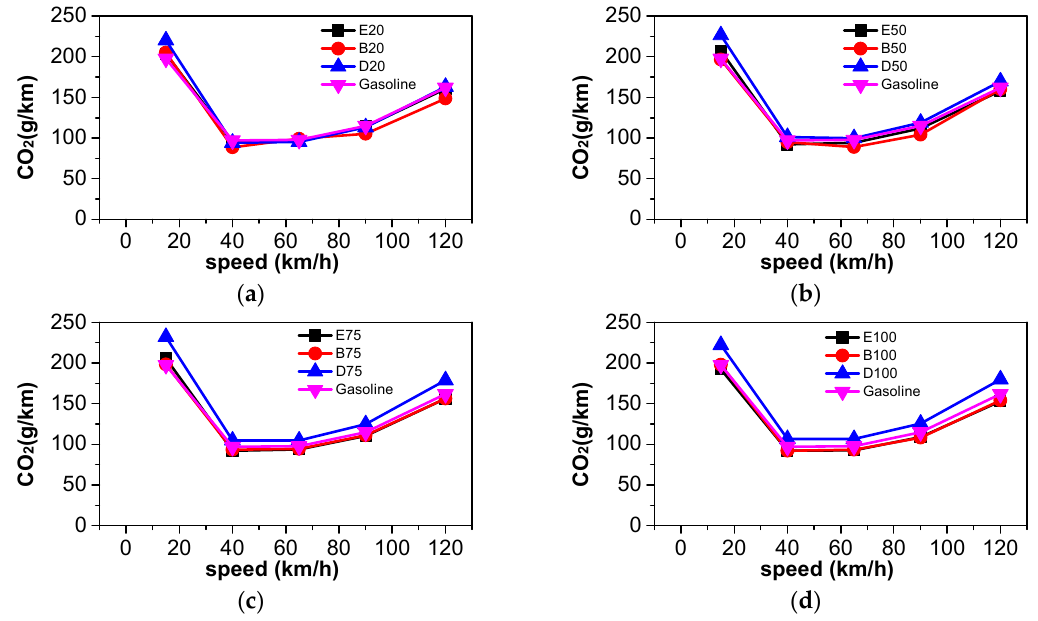
Figure 6. Comparison of CO 2 emissions of different fuels at different blending ratios: (a) 20% blending ratio; (b) 50% blending ratio; (c) 75% blending ratio; and (d) 100% blending ratio.